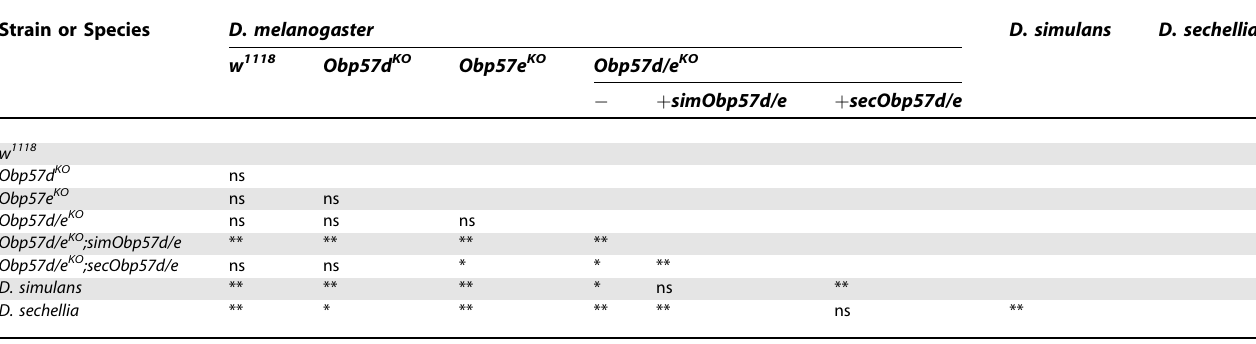
Table 3. Statistical Analysis of Results of Oviposition Site–Preference Assay (Hexanoic Acid) Strain or Species